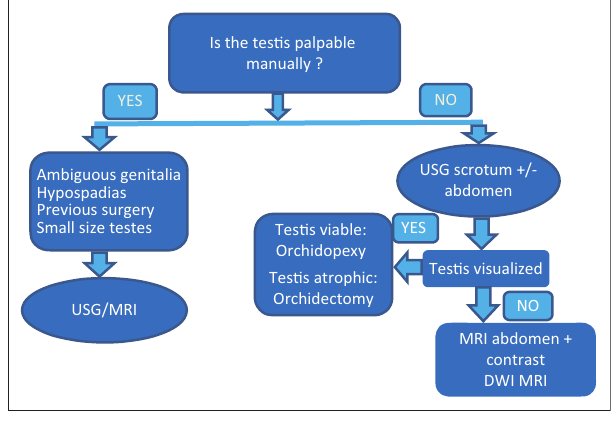
FIGURE 7: Imaging algorithm in undescended testis.